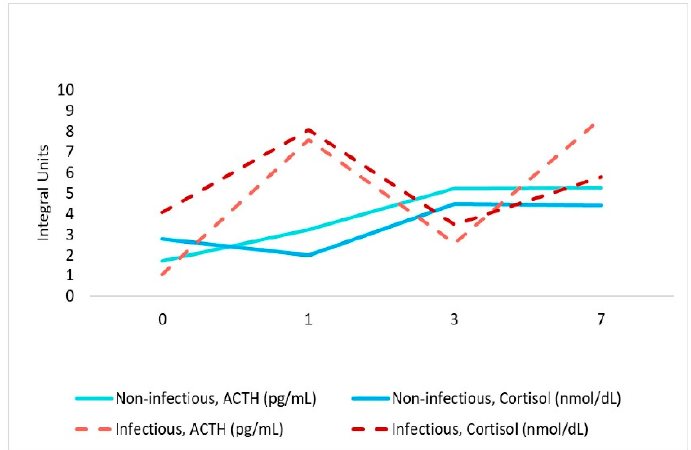
Figure 6. Association between ACTH and cortisol levels in dynamics in patients’ groups.